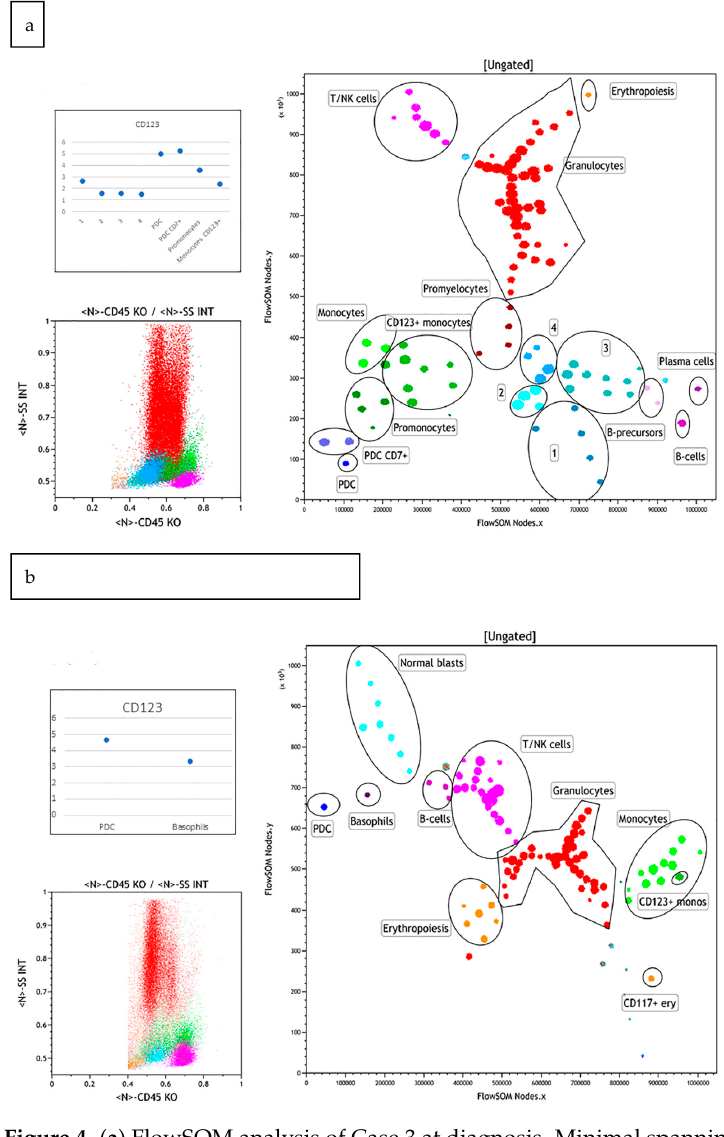
Figure 4. ( a ) FlowSOM analysis of Case 3 at diagnosis. Minimal spanning tree is given in the right panel. The progenitor population is highly heterogeneous and PDC segregates as two different clusters based on CD7 expression (Supplementary Table S6). Normalised MFI of CD123 expression in numbered progenitor subsets and PDCs is illustrated in the upper left diagram and back-gating on the CD45/SSC plot is given in the lower-left panel. ( b ) FlowSOM analysis of Case 3 after induction treatment. Minimal spanning tree is shown in the right panel. Normal partition of cell subsets, including recovery of a single classical PDC node is seen. Normalised MFI of CD123 expression in PDCs and basophils is illustrated in the upper-left diagram and back-gating on the CD45/SSC plot is given in the lower-left